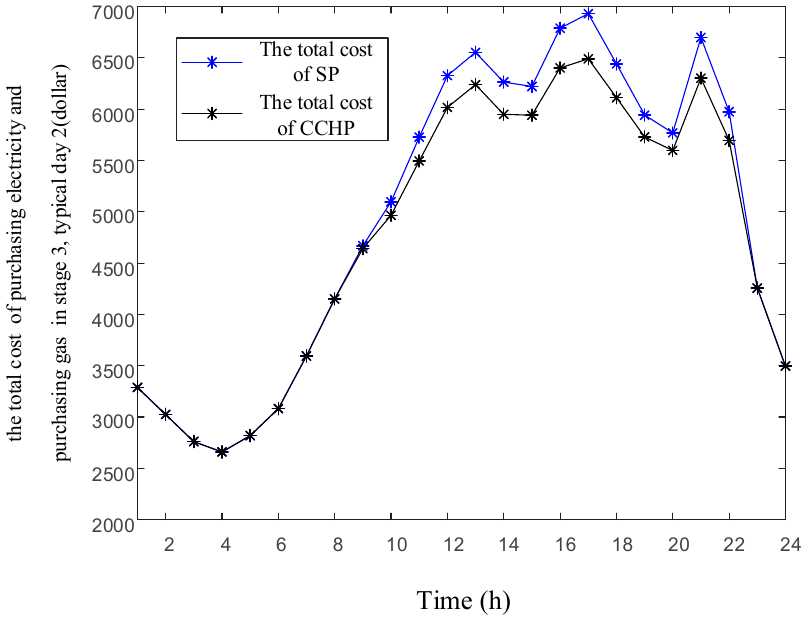
Figure 13. Total cost curves of purchasing electricity and purchasing gas for different cases in stage 3, typical day 2.